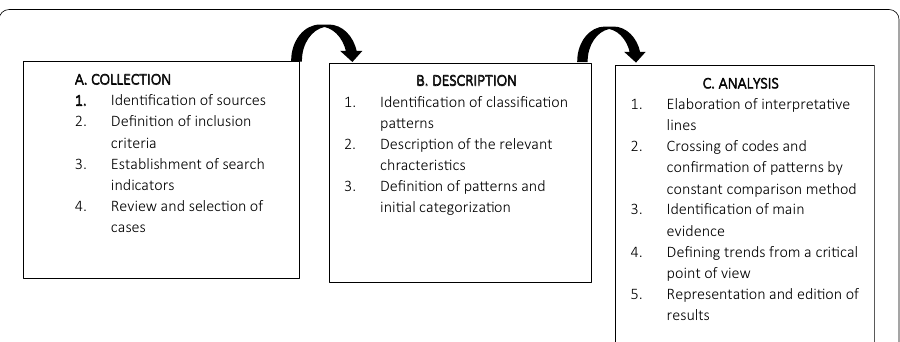
Fig. 2 Stages and specific